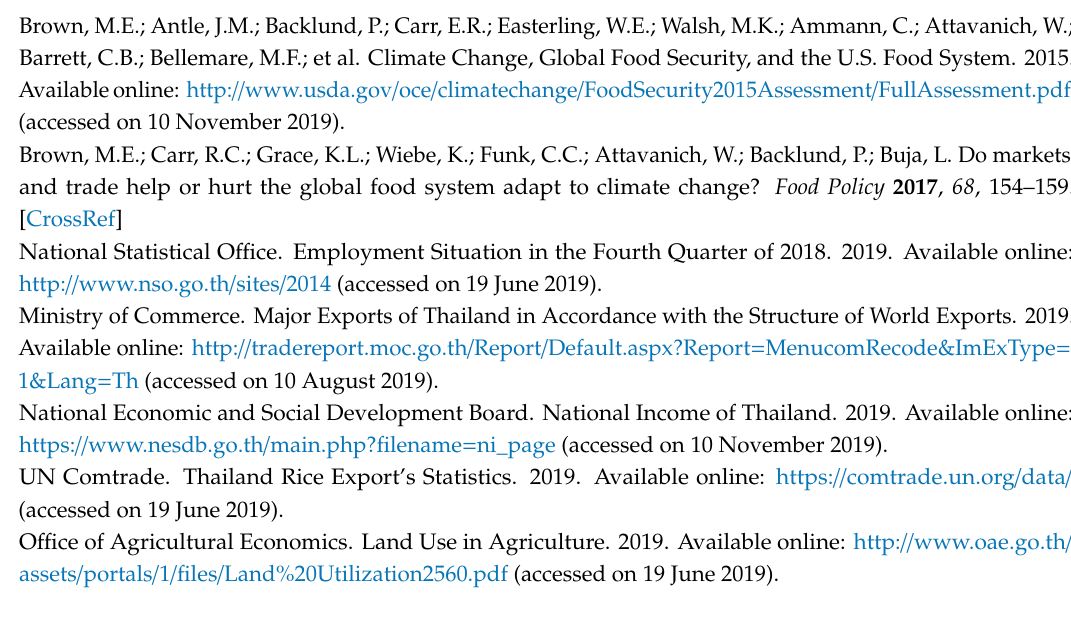
Table S1: Average treatment e ff ects on outcomes using the common support approach; Table S2: Matching quality indicators with the trimming approach corresponding to the potential outcomes with the treatment variable of full land ownership; Table S3: Matching quality indicators with the trimming approach corresponding to the potential outcomes with the treatment variable of weak land ownership; Table S4: Balancing test for the mean di ff erence before and after matching corresponding to the potential outcomes with the treatment variable of full land ownership; Table S5: Balancing test for the mean di ff erence before and after matching corresponding to the potential outcomes with the treatment variable of weak land